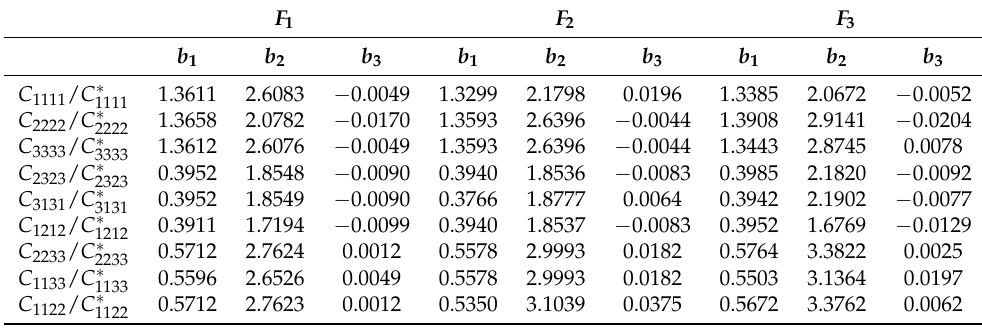
Table 1. Scaling law constants for orthotropic cellular